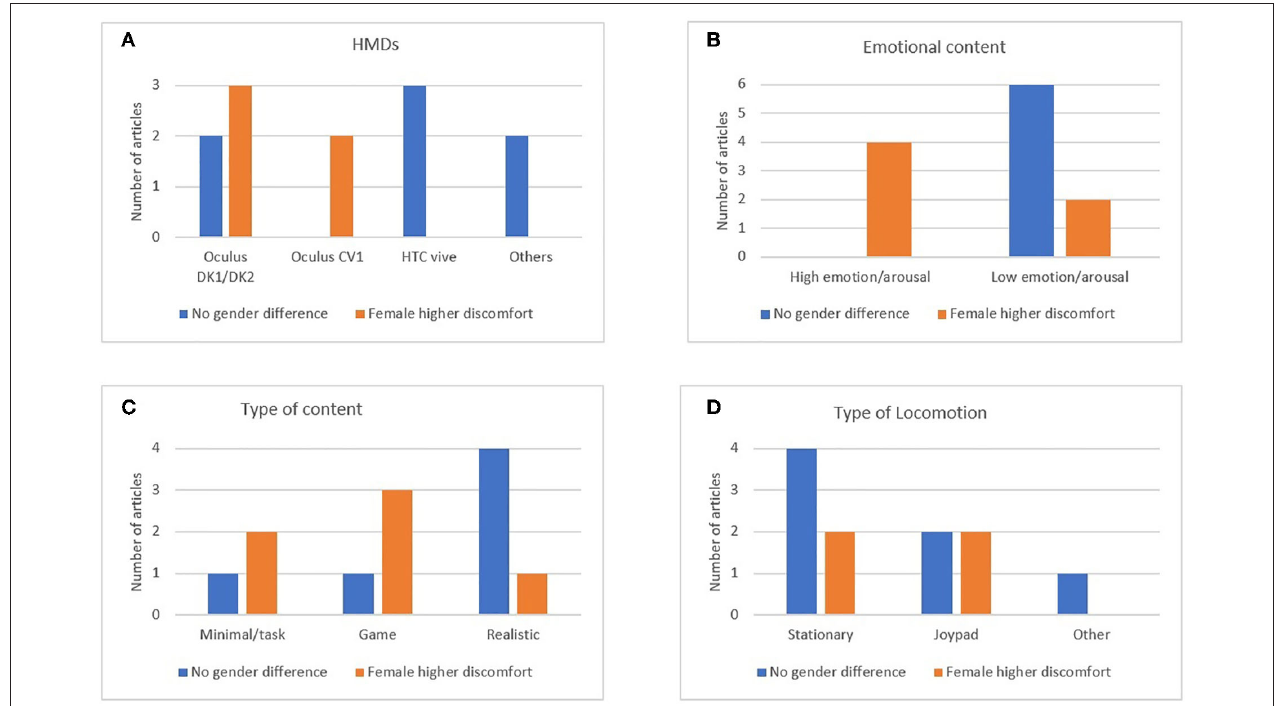
FIGURE 2 | The graphs present the number of studies that reported a different level of discomfort between male and female participants, divided by (A) the type of head-mounted device (HMD), (B) the emotional level in the simulated environment, (C) the type of virtual reality content, and (D) the type of locomotion experienced in the virtual